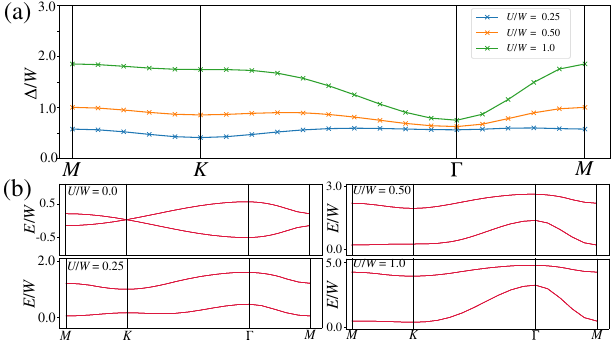
FIG. 7. QVH insulator and band structures. (a) Single-particle gap Δ =W along the high-symmetry path of the BZ with α ¼ 0 . 45 and various interaction strengths. The Dirac cones are gapped at infinitely small U , and the system enters the QVH state. The maximal gap value gradually shifts from Γ to K . (b) Band structures at various interaction strengths with α ¼ 0 . 45 . The top- left plot displays the bare kinetic bands in the absence of any interactions. The Dirac cone at K is evident and confirms the semimetallic phase of the bare bands. The remaining three plots of (b) present the renormalized band structures with increasing U . The two bands flatten for small U and gradually develop a peak at Γ . All bands are fourfold degenerate, as the QVH phase does not break the approximate SU ð 4 Þ